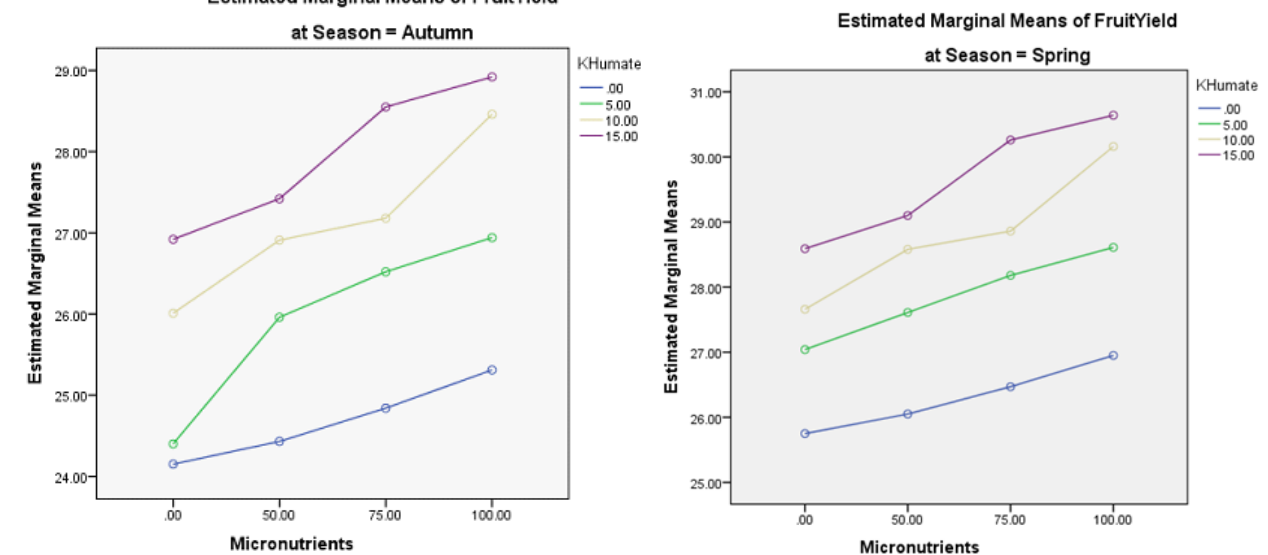
Figure 1. Interaction graphs for total fruit yield obtained under K-humate and micronutrients mixture applied in the autumn and spring seasons.